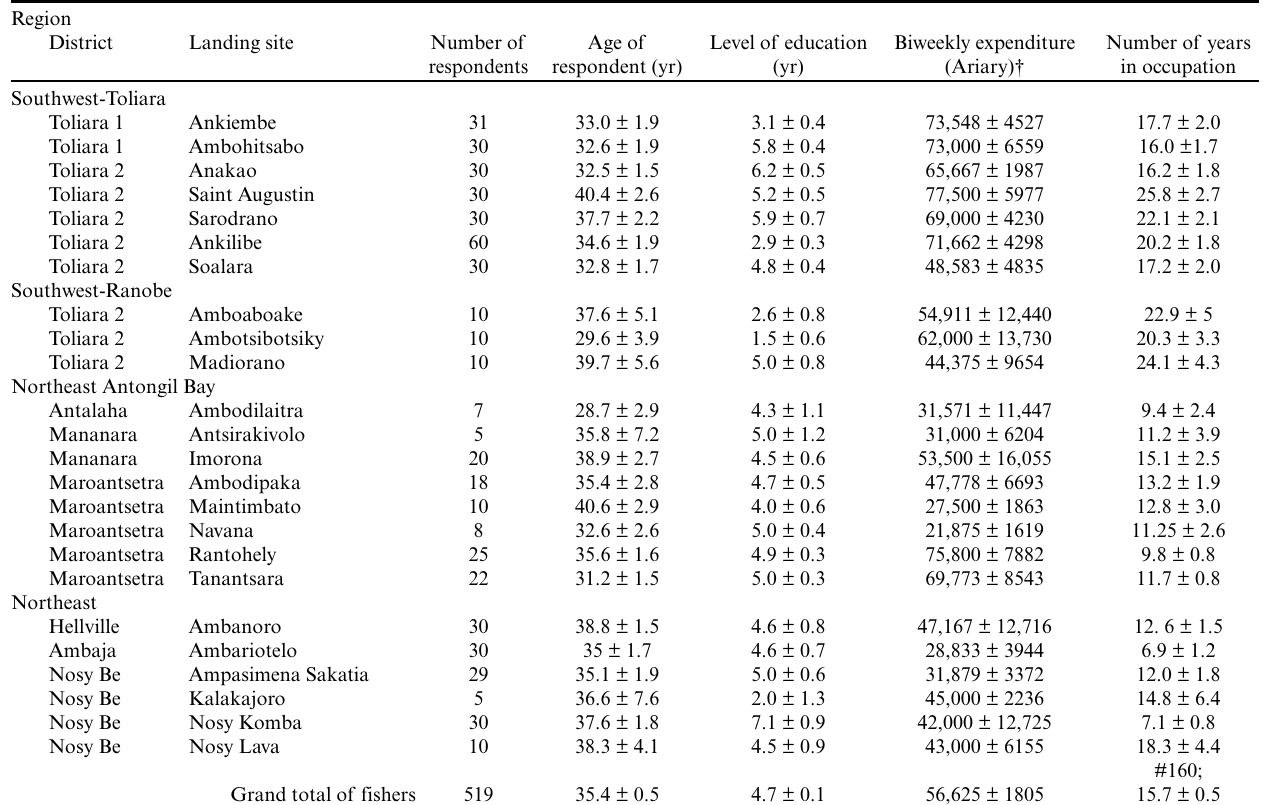
Table 2. Respondent characteristics showing sites, sample size, and mean ± SE of age of respondent, level of education, biweekly expenditure, perceived mean disparity, and numbers of years in occupation. There are two coastal districts in the Toliara Province. Region District